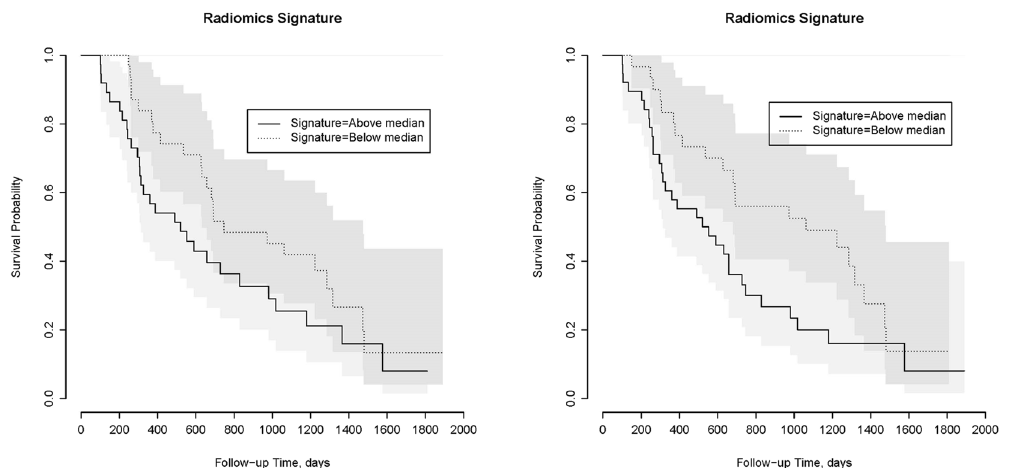
Figure 3. Kaplan-Meier plots for OS using Radiomic Signature. Left: Kaplan-Meier plots for OS for the validation cohort with Reader 1 contours dichotomized based on the median values of Radiomic Signature in the training cohort; hazard ratio: 1.56 (CI: 1.15–2.13), P-Value: 0.005, ICC: 0.63. Right: Kaplan-Meier plots for OS for the validation cohort with Reader 2 contours dichotomized based on the median values of Radiomic Signature in the training cohort; hazard ratio: 1.35 (CI: 1.04–1.75), P-Value = 0.022, ICC